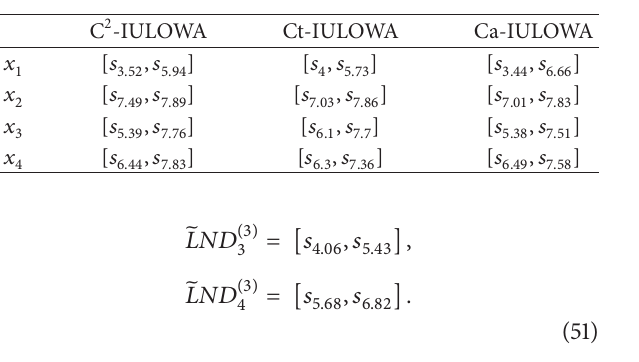
Table 7: Collective non-dominance degrees of alternatives by utilizing C 2 -IULOWA, Ct-IULOWA, and Ca-IULOWA operators.